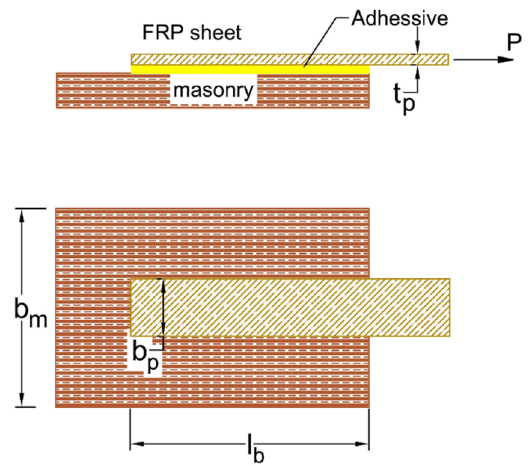
Figure 1. Adhesive-bonded joint [24].